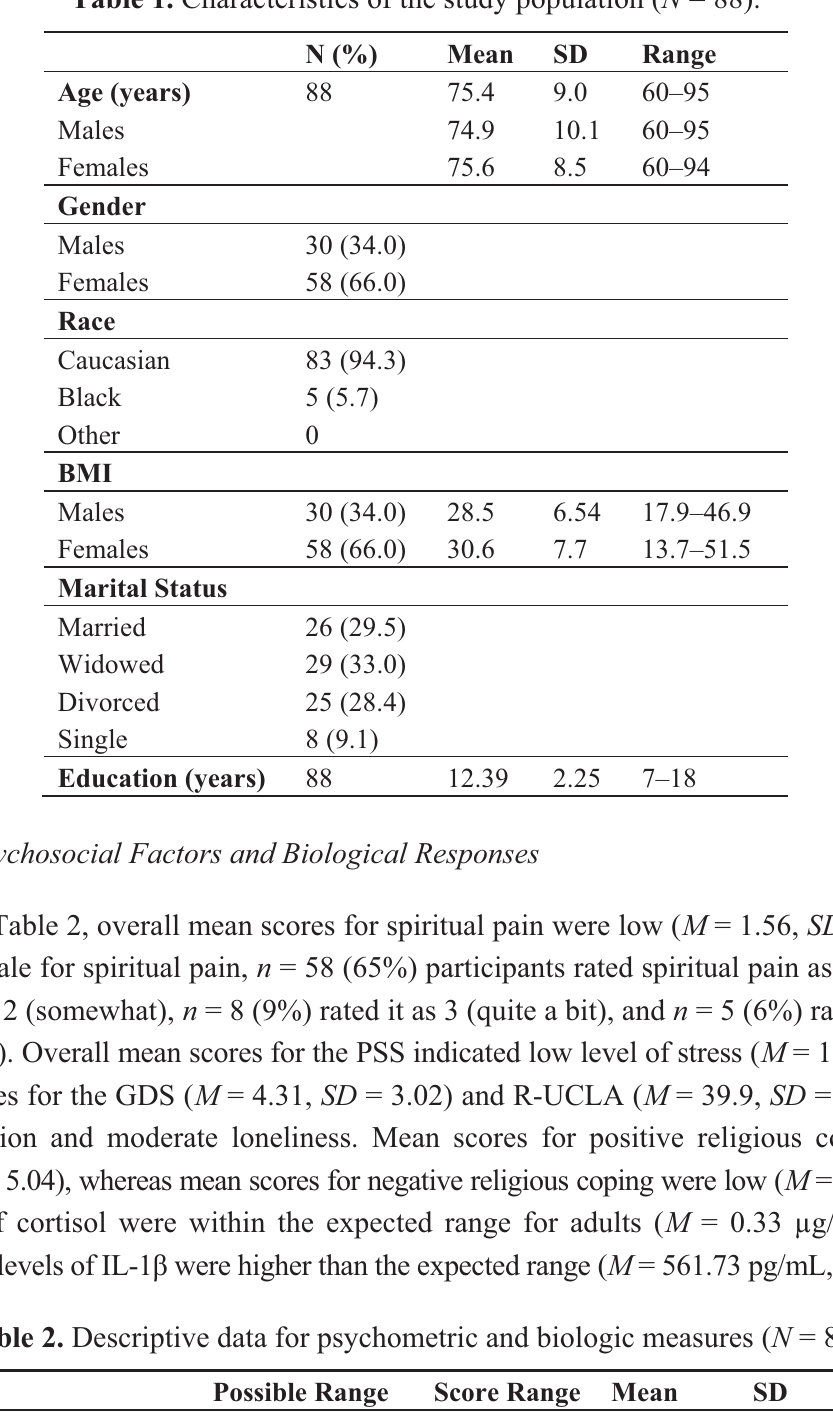
Table 1. Characteristics of the study population ( N = 88).